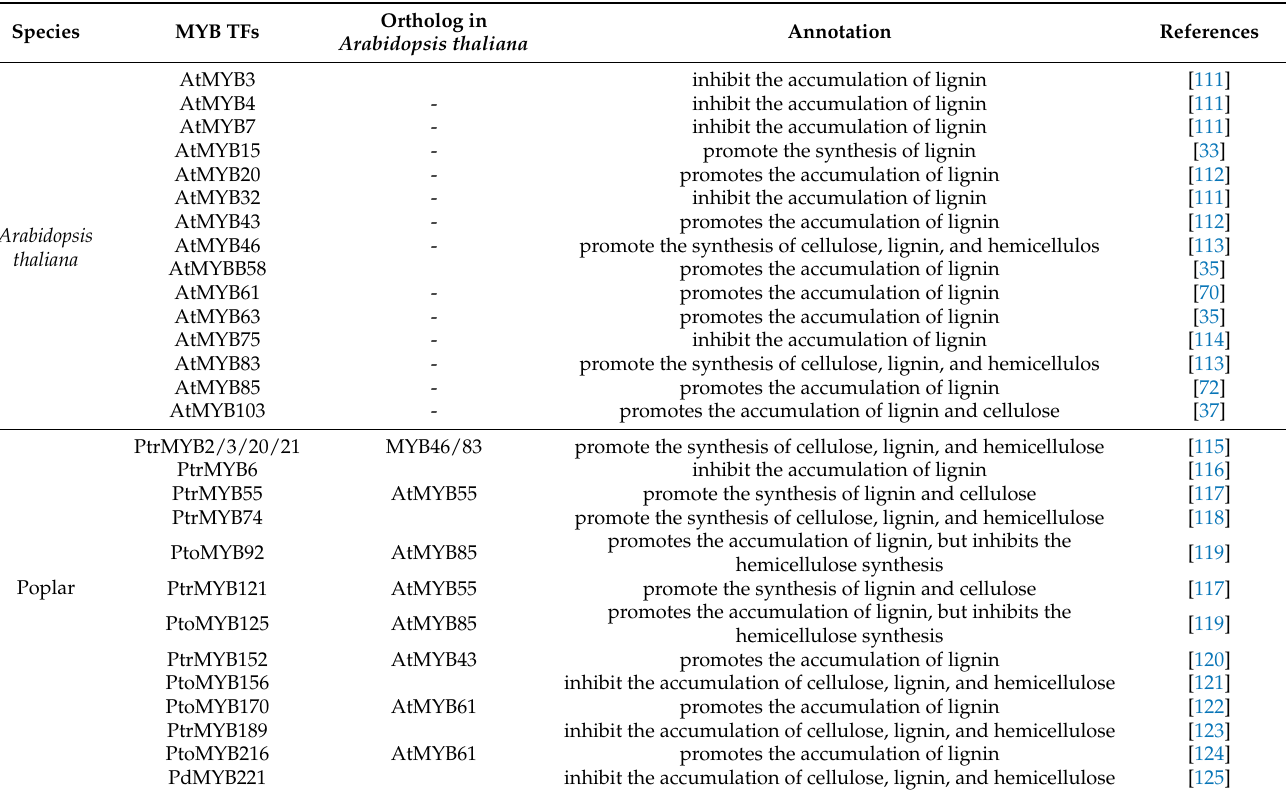
Table 2. The main MYB transcription factor that regulates secondary wall synthesis in Arabidopsis and poplar. Ortholog in Species MYB TFs Arabidopsis thaliana